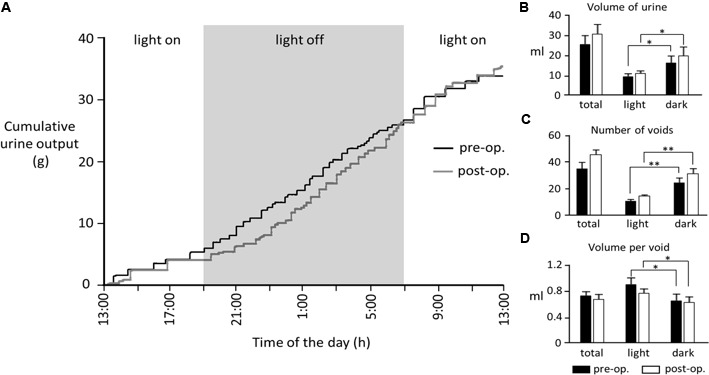
(A) Cumulative 24-h urine output from a rat measured 6 days prior to and 4 days post-surgery. (B–D) Bar graphs show pooled data from five rats. In the remaining animals, 24-h data sets were incomplete due to computer crashes during data acquisition. ∗p < 0.05, ∗∗p < 0.01 (Wilcoxon signed-rank test).